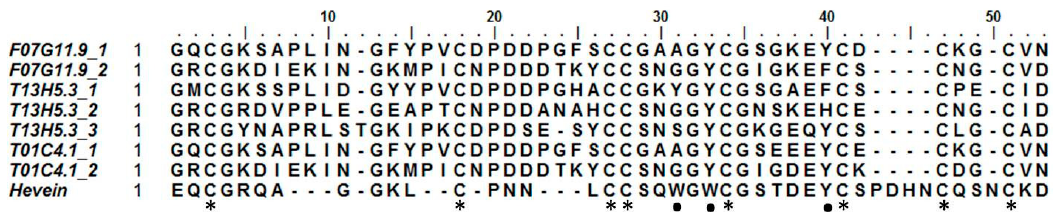
Figure 1. Alignment of the eight discovered hevein domains in Caenorhabditis elegans with the original hevein peptide from Hevea brasiliensis . Asterisks indicate the eight conserved cysteine residues forming four disulfide bridges; dots show the aromatic amino acids and serine residue involved in chitin binding.